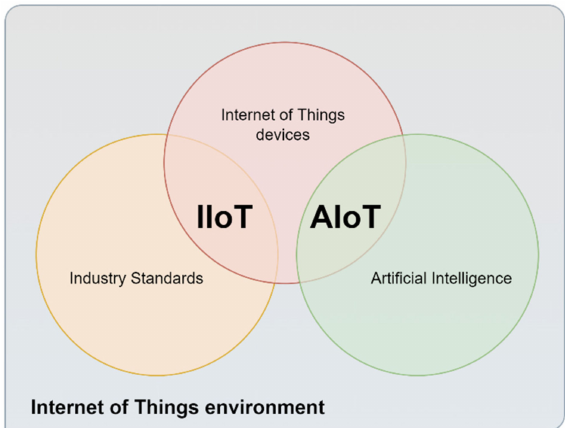
Figure 7. Relationship between AIoT and IIoT devices in IoT